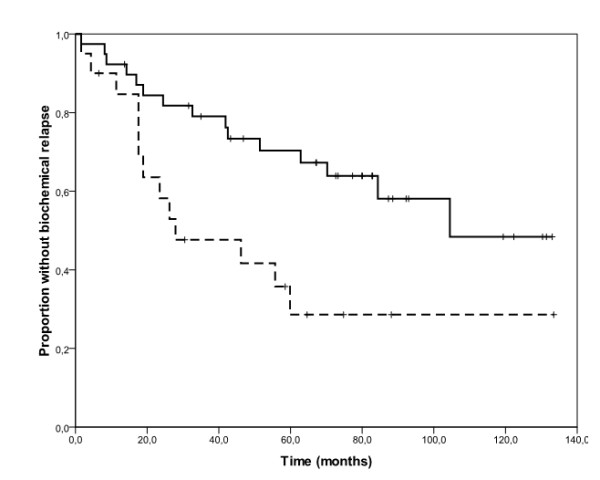
Kaplan-Meier estimates of time to biochemical relapse according to EGFR immunohistochemical status. The solid line represents patients with EGFRlow tumours and the dashed line represents those with EGFRhigh tumours. Median time to biochemical relapse was 104 and 30 months for patients with EGFRlow and EGFRhigh tumours, respectively (log-rank test, p=0.01).